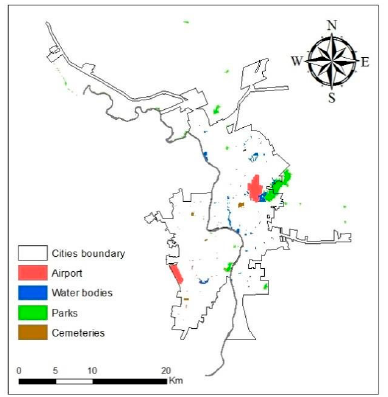
Figure 5. Protected areas excluded for the analysis.